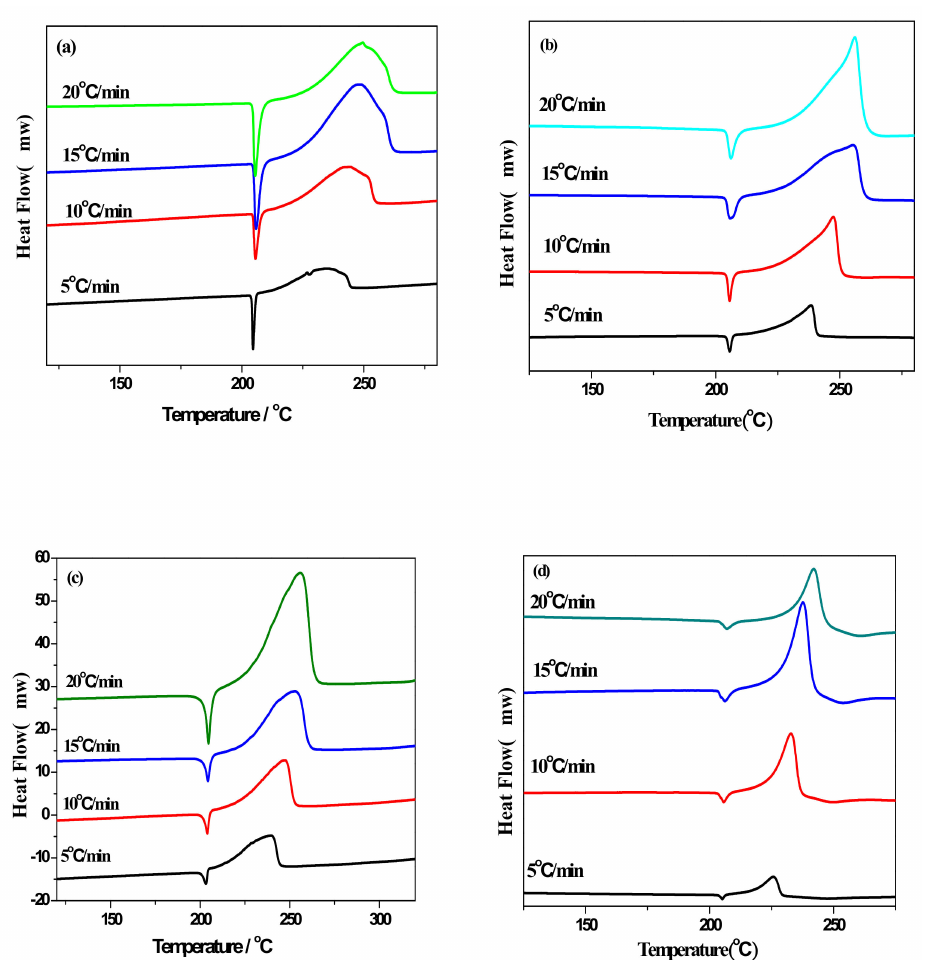
Figure 7. DSC curves of RDX particles: ( a ) Raw RDX; ( b ) Refined RDX; ( c ) RDX / MU-1; ( d ) RDX /